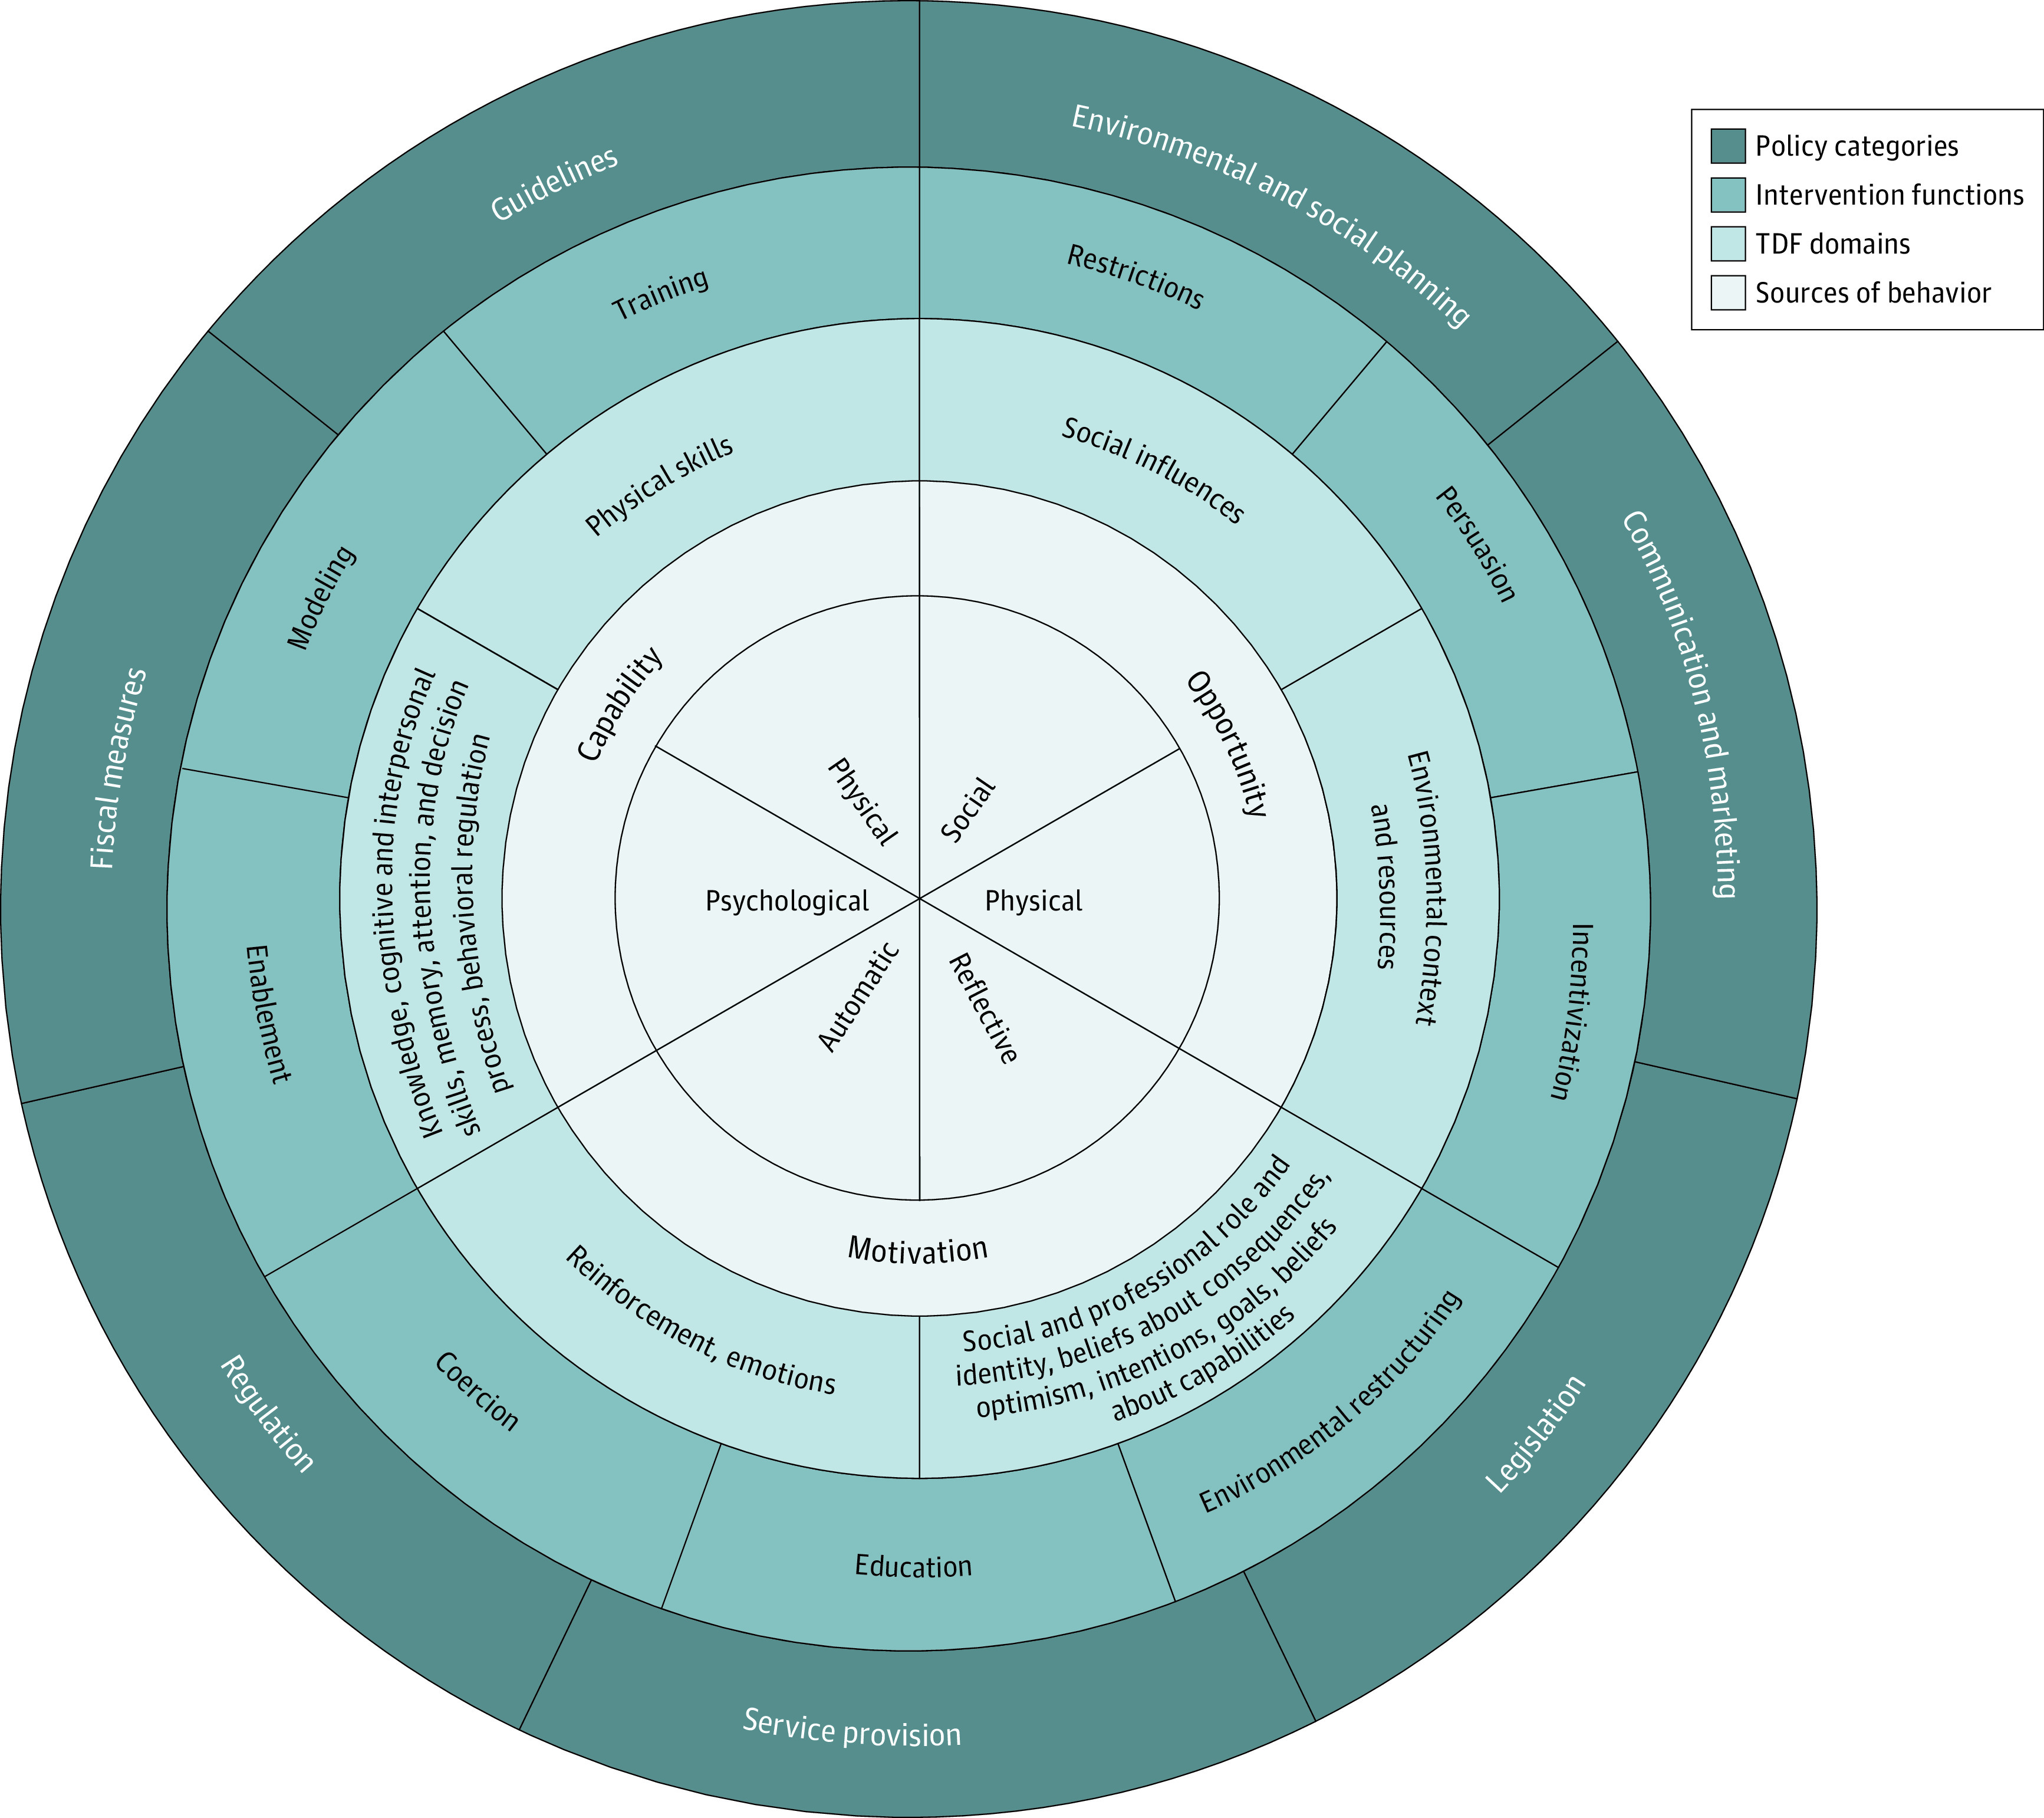
Behavior WheelTDF indicates Theoretical Domains Framework.